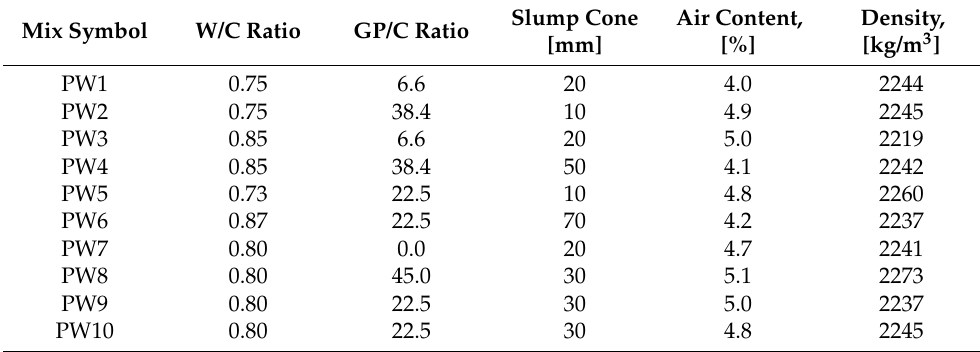
Table 3. Consistency, air content and density of the tested concrete